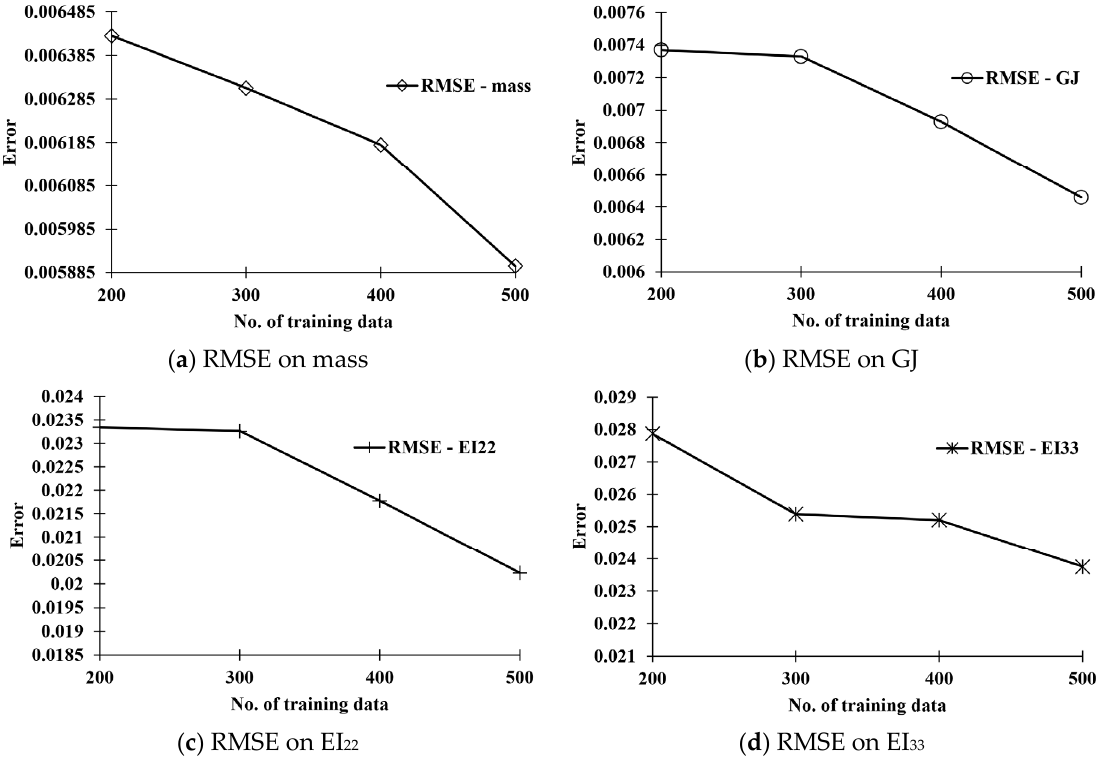
Figure 16. RMSE according to variation of training data.